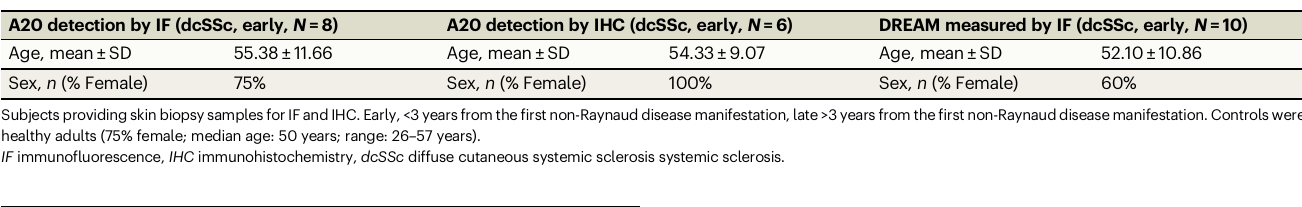
Table 2 | Gene expression in never-cultured skin fi broblasts 11 (Gardet et al., Sci. Rep. 2019, GSE TBD)